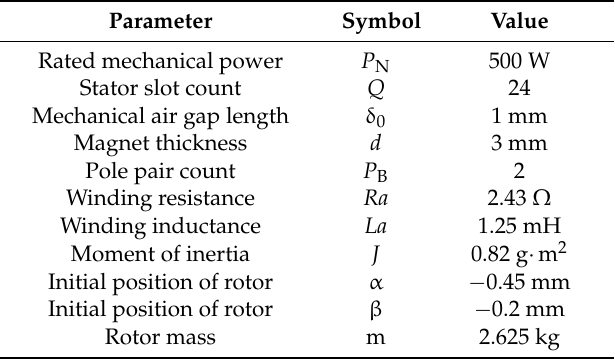
Table 1. Parameters of SBPMSM.